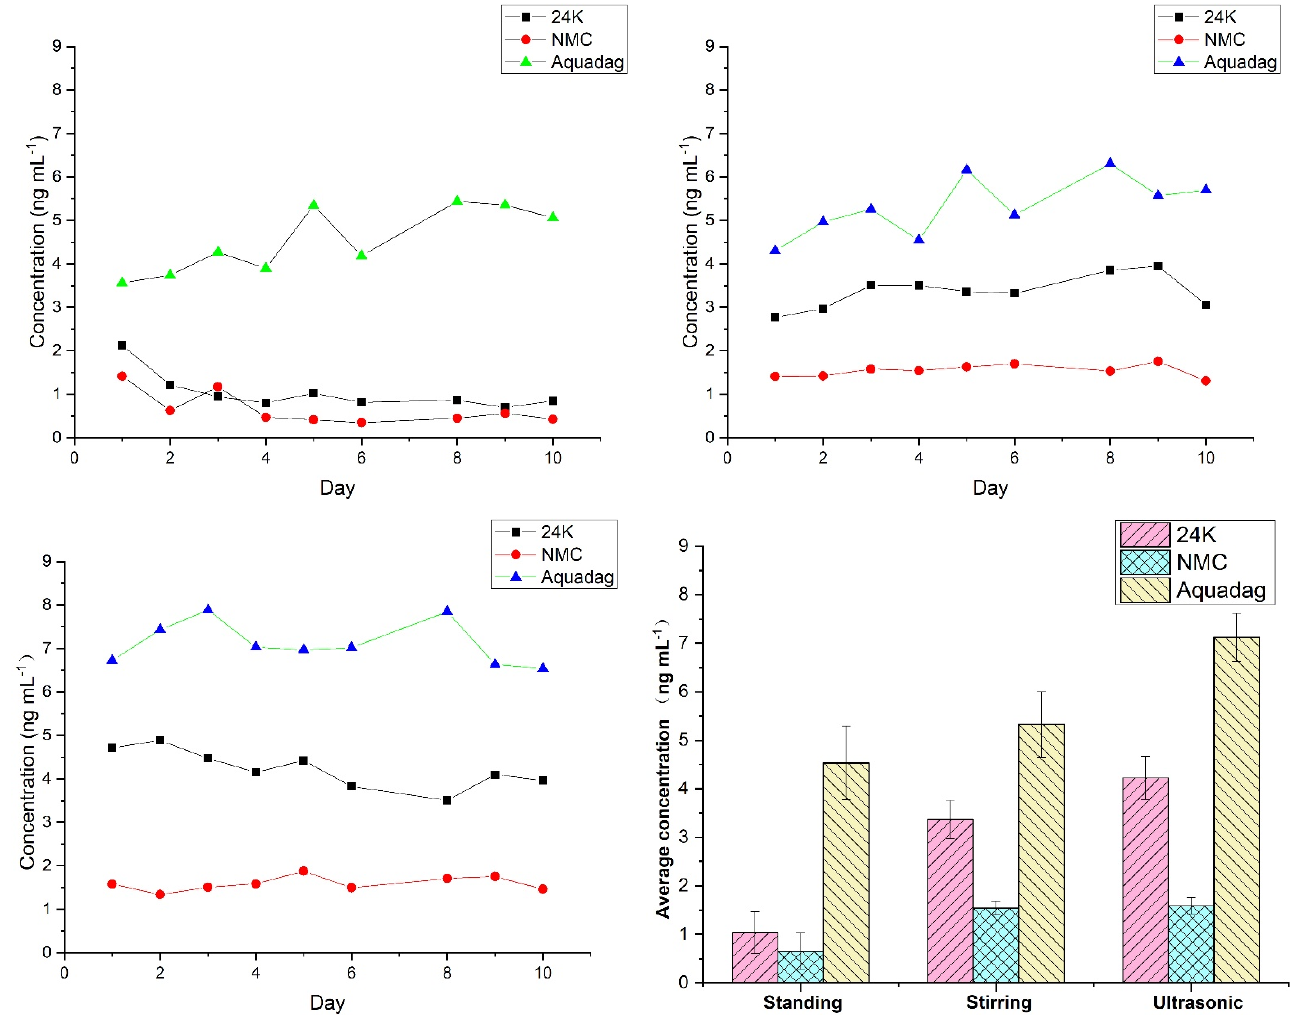
Figure 2. Change in black carbon concentration in static, stirring, and ultrasonic methods and concentration comparison in three treatment methods.